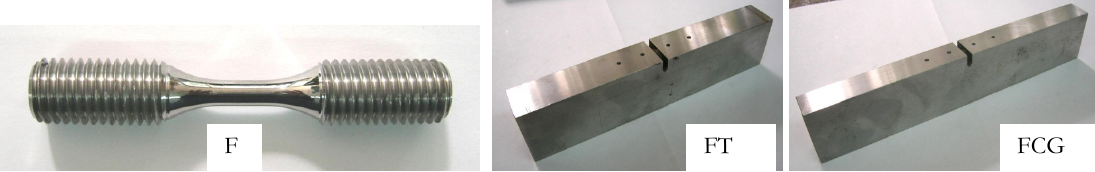
Figure 2: Specimens prototypes used for the testing